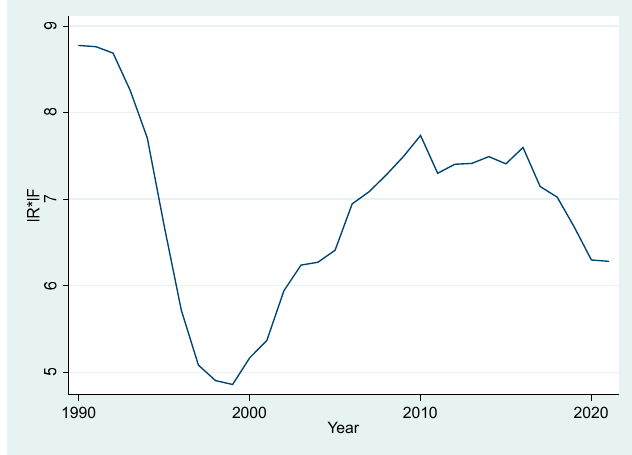
Figure A1. Time trend of variables for Sweden.